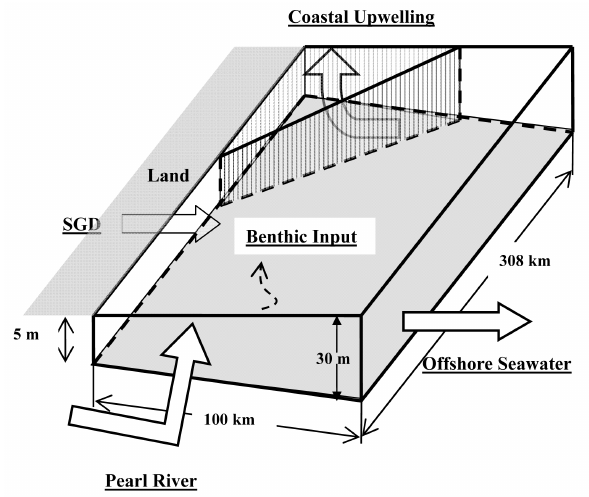
Fig. 9. Schematic of a mass balance box model of long-lived Ra iso- topes ( 228 Ra and 226 Ra) on the northern South China Sea shelf cov- ering the seven cross-shelf transects (see Fig. 1) extending 308km alongshore, 100km offshore, with mixed layer depths from 5 to 30m. Sources of Ra include Pearl River, benthic input, coastal up- welling and submarine groundwater discharge